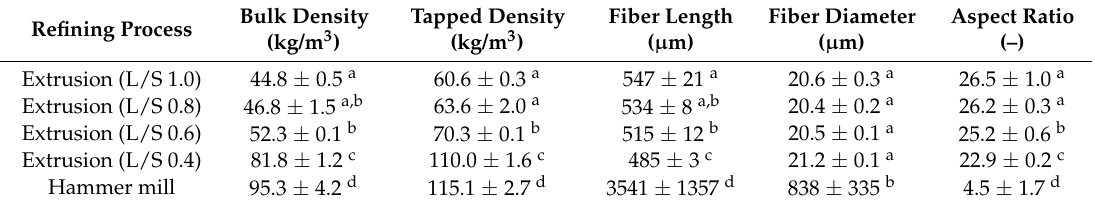
Figure 1. Macrographs of the coriander straw materials resulting from different refining processes. ( a ) Extrusion refining with a liquid/solid (L/S) ratio of 1.0; ( b ) Extrusion refining with a L/S ratio of 0.8; ( c ) Extrusion refining with a L/S ratio of 0.6; ( d ) Extrusion refining with a L/S ratio of 0.4; ( e ) Grinding process using a hammer mill. Table 2. Density and morphological characteristics of refined coriander straw. L/S, liquid/solid. Refining Process Extrusion (L/S